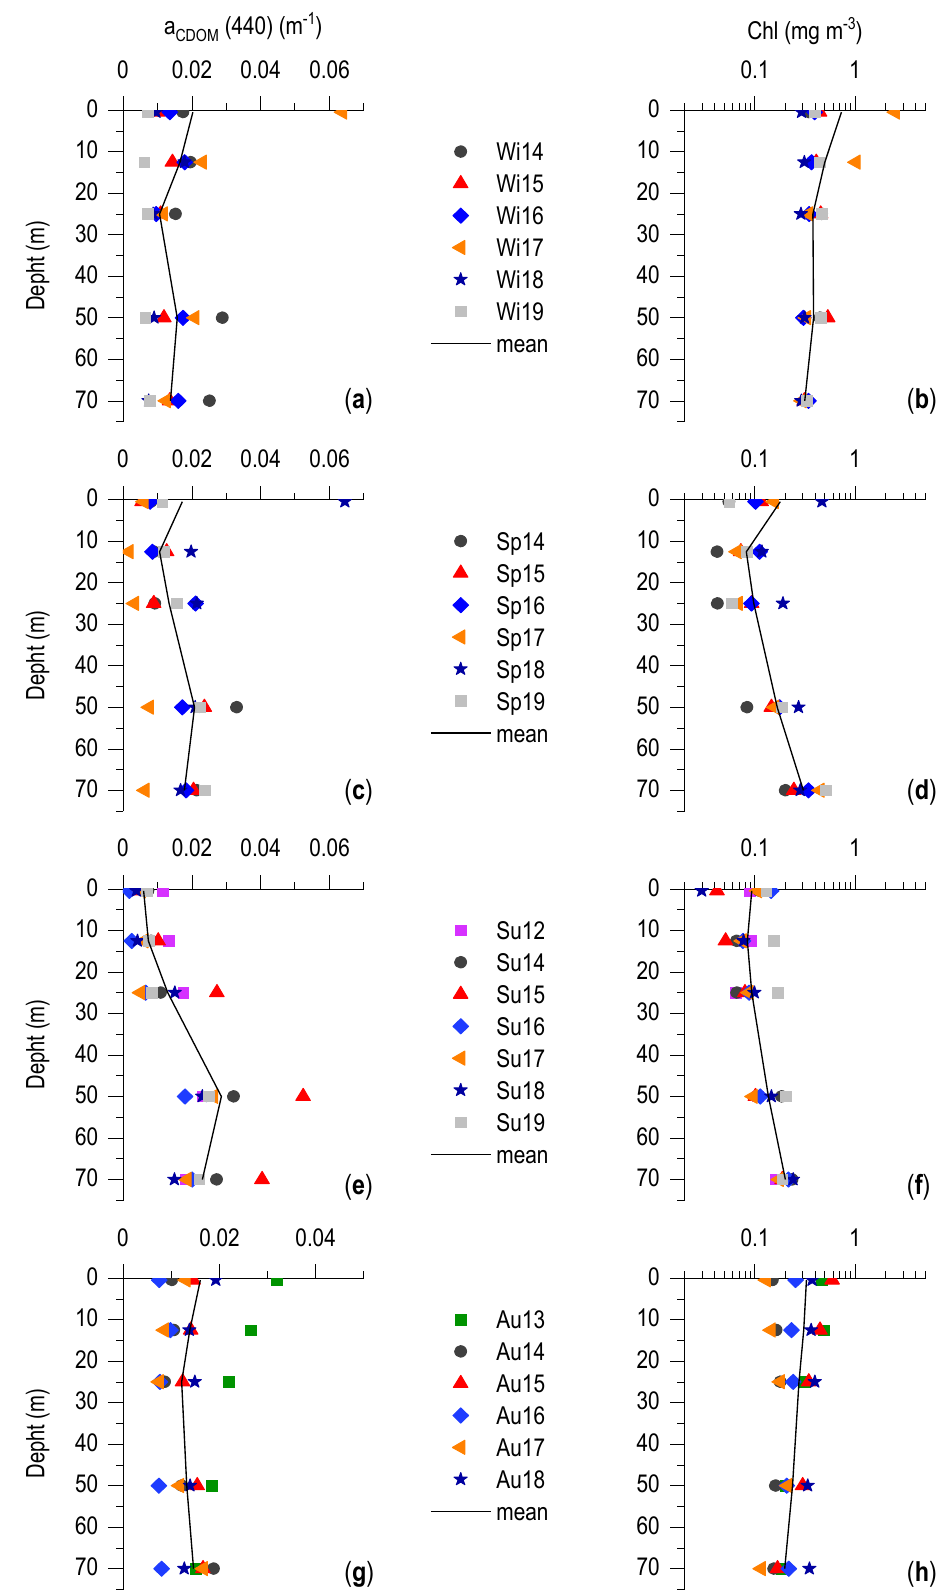
Figure 5. Vertical profiles of: ( a , c , e , g ) a CDOM (440) (m − 1 ); ( b , d , f , h ) Chl (mg m −3 ) in the four seasons: winter (Wi); spring (Sp); summer (Su); autumn (Au).